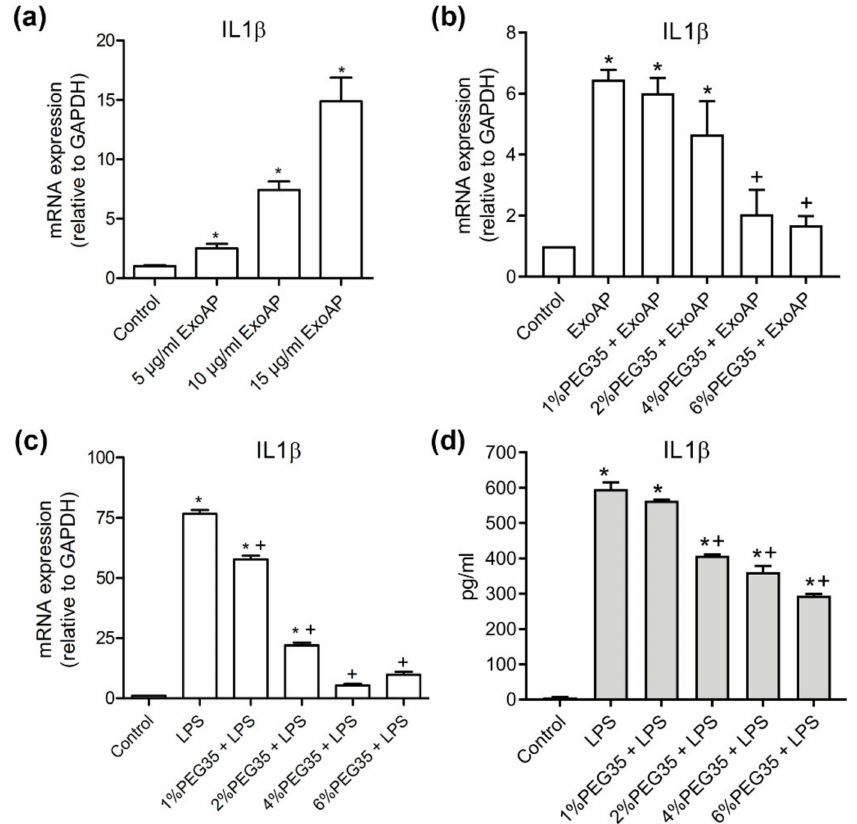
Figure 4. Expression of pro-inflammatory Interleukin 1 β (IL1 β ) in THP-1-treated cells: ( a ) Gene expression by real-time qRT-PCR of IL1 β in THP-1 macrophages treated with increasing concentrations of ExoAP; ( b ) gene expression by real-time qRT-PCR of IL1 β by THP-1 cells subjected to increasing concentrations of PEG35 and co-incubated with ExoAP; ( c ) IL1 β gene expression by real-time qRT-PCR in THP-1 macrophages subjected to increasing concentrations of PEG35 and co-incubated with lipopolysaccharide (LPS), where, in all cases, mRNA induction levels were normalized to glyceraldehyde-3-phosphate dehydrogenase (GAPDH) mRNA expression; and ( d ) expression levels of IL1 β protein released by THP-1 cells pretreated with increasing concentrations of PEG35 and then co-incubated with LPS. Bars represent the mean values of each group ± SEM. * p < 0.05 versus control, + p < 0.05 versus ExoAP or LPS. Each determination was carried out in triplicate. ExoAP, exosomes from acute-pancreatitis-induced rats; LPS, lipopolysaccharide; PEG35, 35-kDa polyethylene glycol; and IL1 β , interleukin 1 β